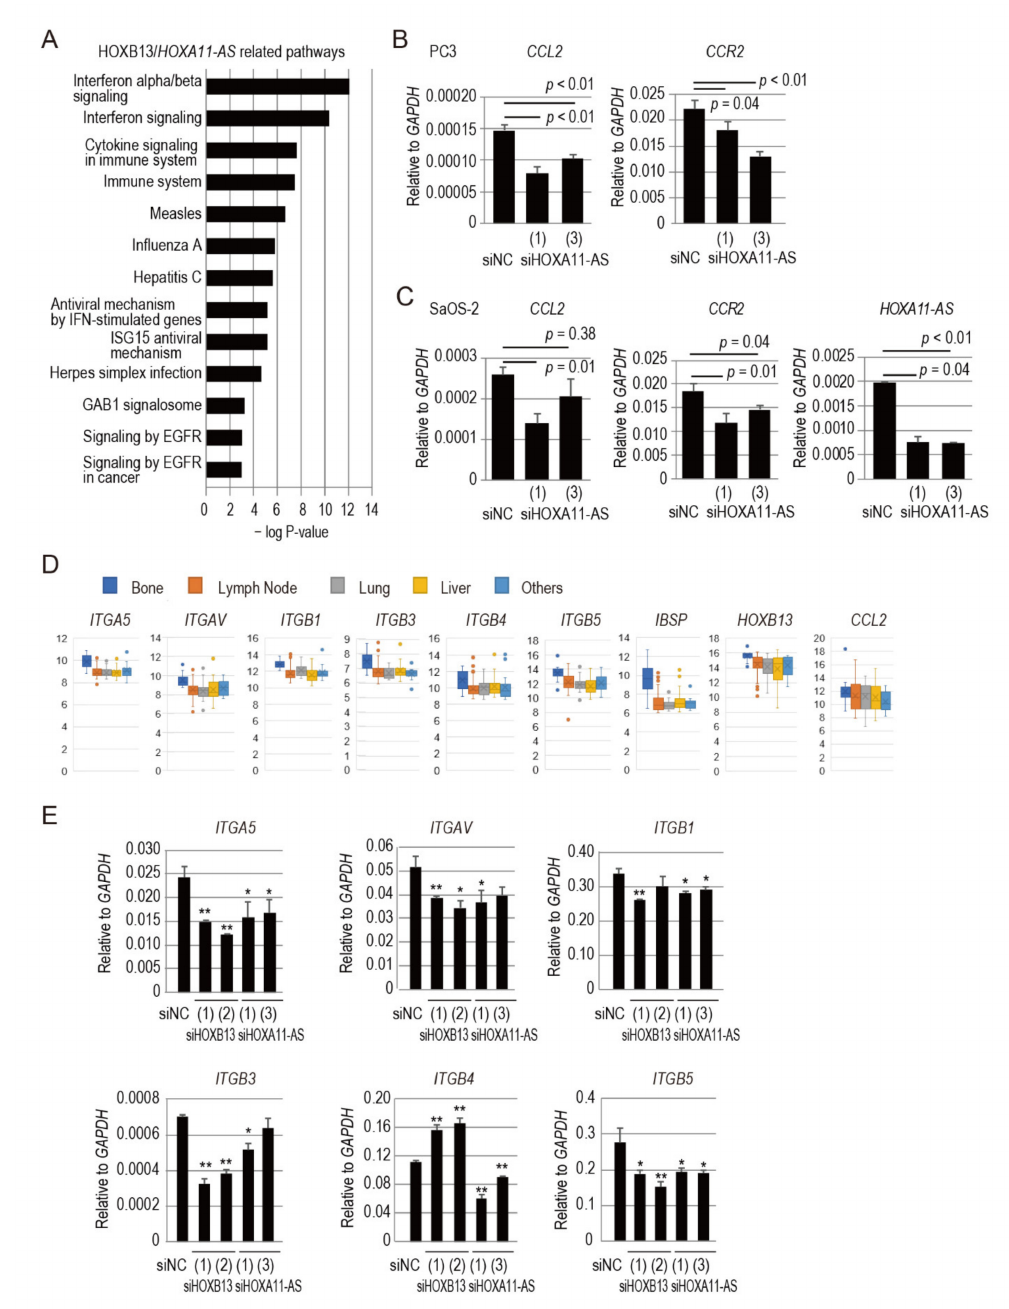
Figure 3. HOXB13/ HOXA11-AS axis regulates CCL2/CCR2 signaling and integrin subunits specific to prostate cancer bone metastasis. ( A ) Pathway analysis of HOXB13/ HOXA11-AS -regulated genes. Most relevant signaling pathways with lower p values are shown. ( B ) qPCR analysis of CCL2 and CCR2 in PC3 cells transfected for 48 h with siHOXA11-AS. ( C ) qPCR analysis of CCL2 , CCR2 , and HOXA11-AS in SaOS2 cells transfected for 24 h with siHOXA11-AS. ( D ) Expression analysis of different integrin subunits, IBSP, HOXB13 , and CCL2 , in castration-resistant prostate cancer clinical specimens that had metastasized to bone and other organs. A set of clinical samples from the NCBI Gene Expression Omnibus database (GEO Accession No. GSE74685) was analyzed. Values on y -axis represent batch-normalized log2 Cy3 signal intensity. ( E ) qPCR analysis of different integrin subunits ( ITGA5 , ITGAV , ITGB1 , ITGB3 , ITGB4 , and ITGB5 ) of PC3 cells transfected for 48 h with siHOXB13 and siHOXA11-AS. qPCR analyses were performed in triplicate ( n = 3). Expression levels are presented relative to values of GAPDH , used as a reference gene. Values represent mean ± standard deviation. Statistical significance was determined by unpaired t -tests. *, p < 0.05. **, p <